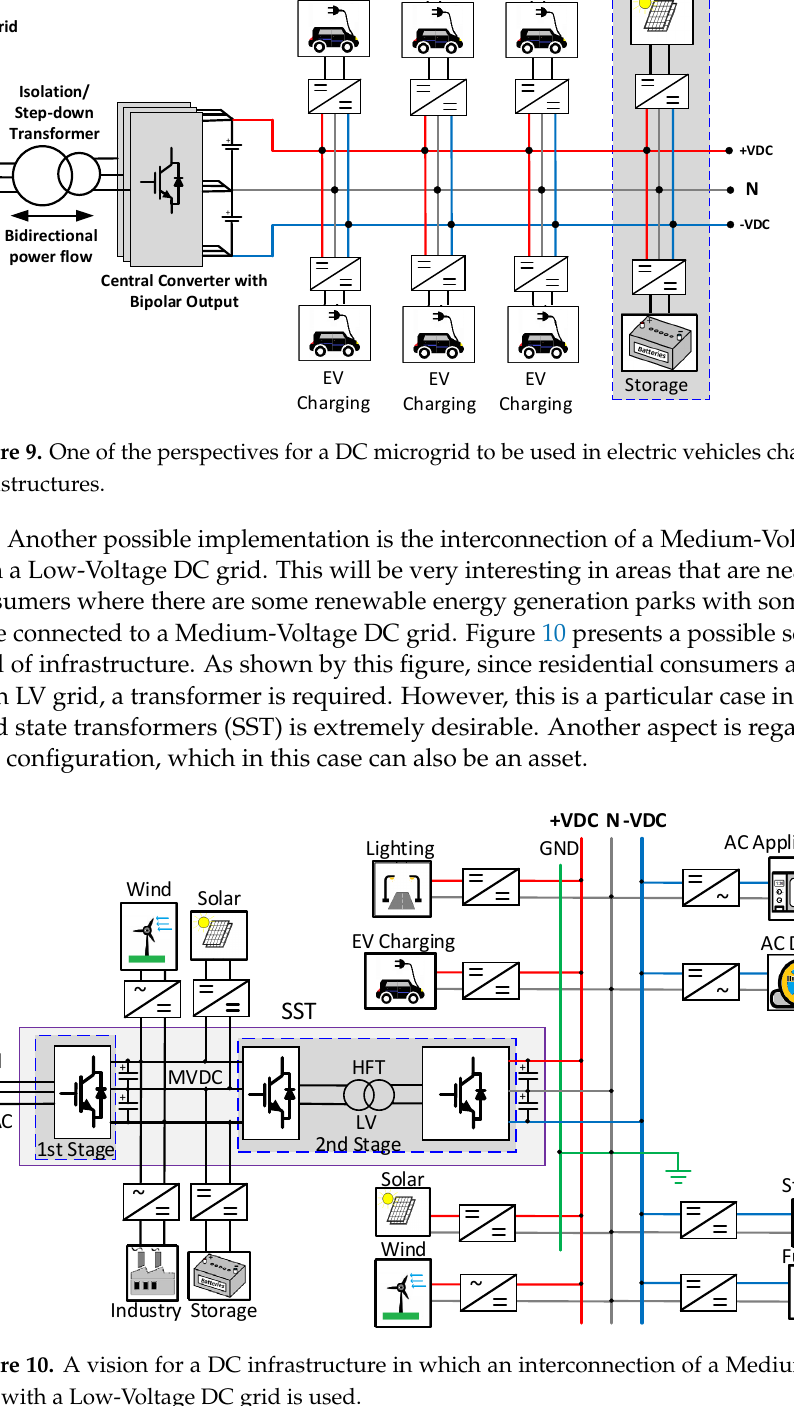
( b ) Figure 11. Possible structure of the electrical infrastructure for individual residential level: ( a ) only a DC network and ( b ) parallel infrastructure of AC and DC networks. Another aspect that is similar to the one presented for the individual residential houses is buildings (residential or offices). In this case, the same parallel infrastructure can be considered as one of the most desirable. One perspective for one simplified scheme